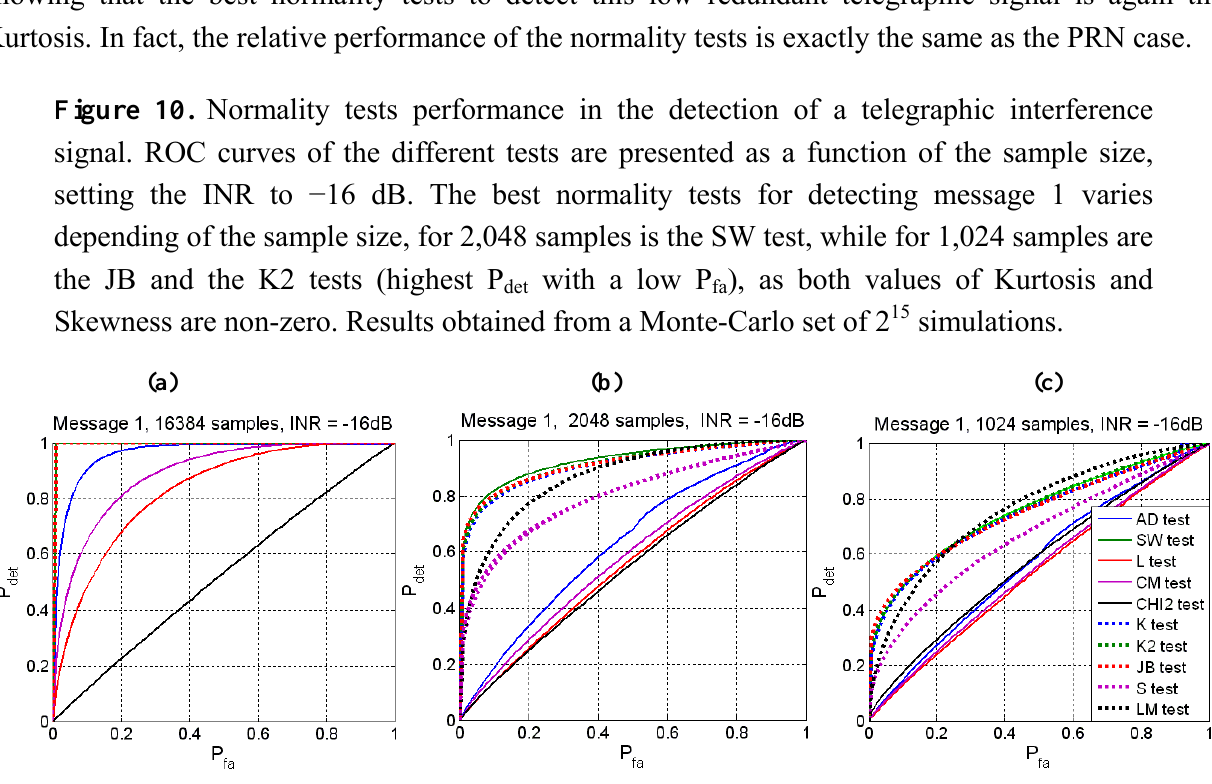
Figure 11. Normality test performance in the detection of a telegraphic interference